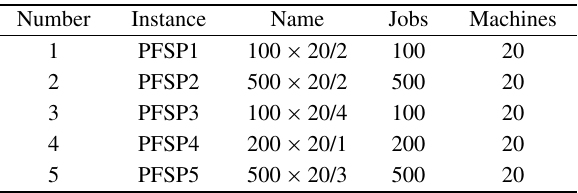
Table 4 Permutation flow shop instance.